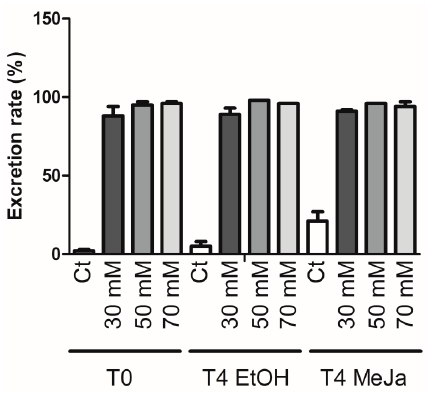
Figure 9. Excreted stilbenes as a proportion of total stilbenes in response to MeJA, MCDs and in combination. Each point represents the mean with standard deviation of three biological replicates.